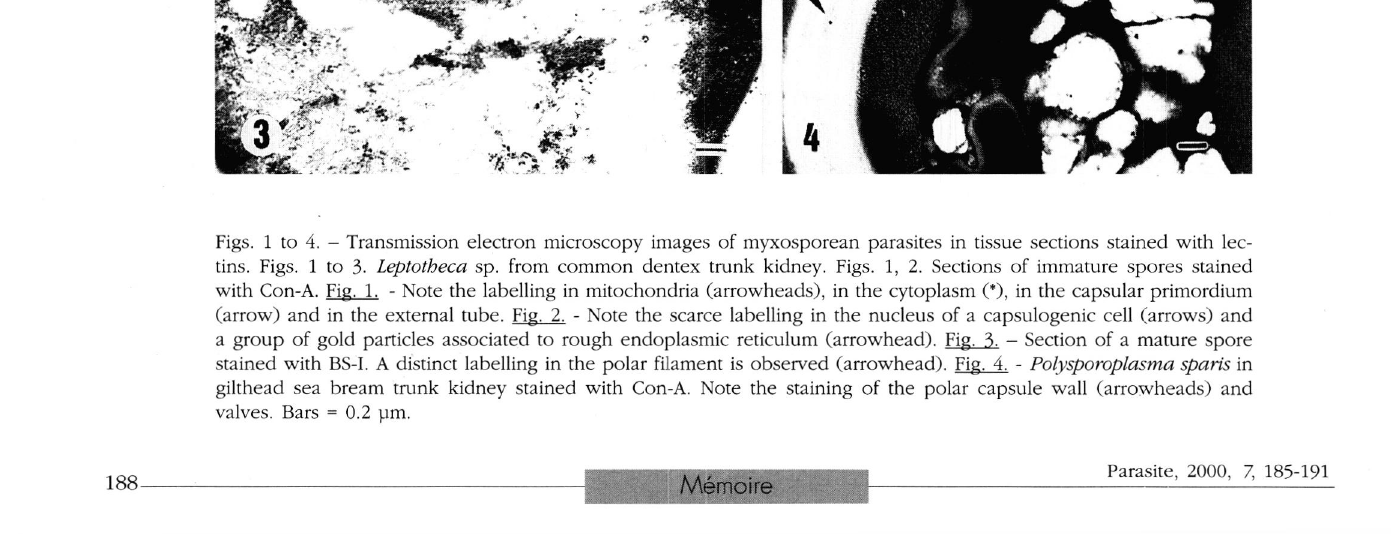
Parasite, 2000, 7,